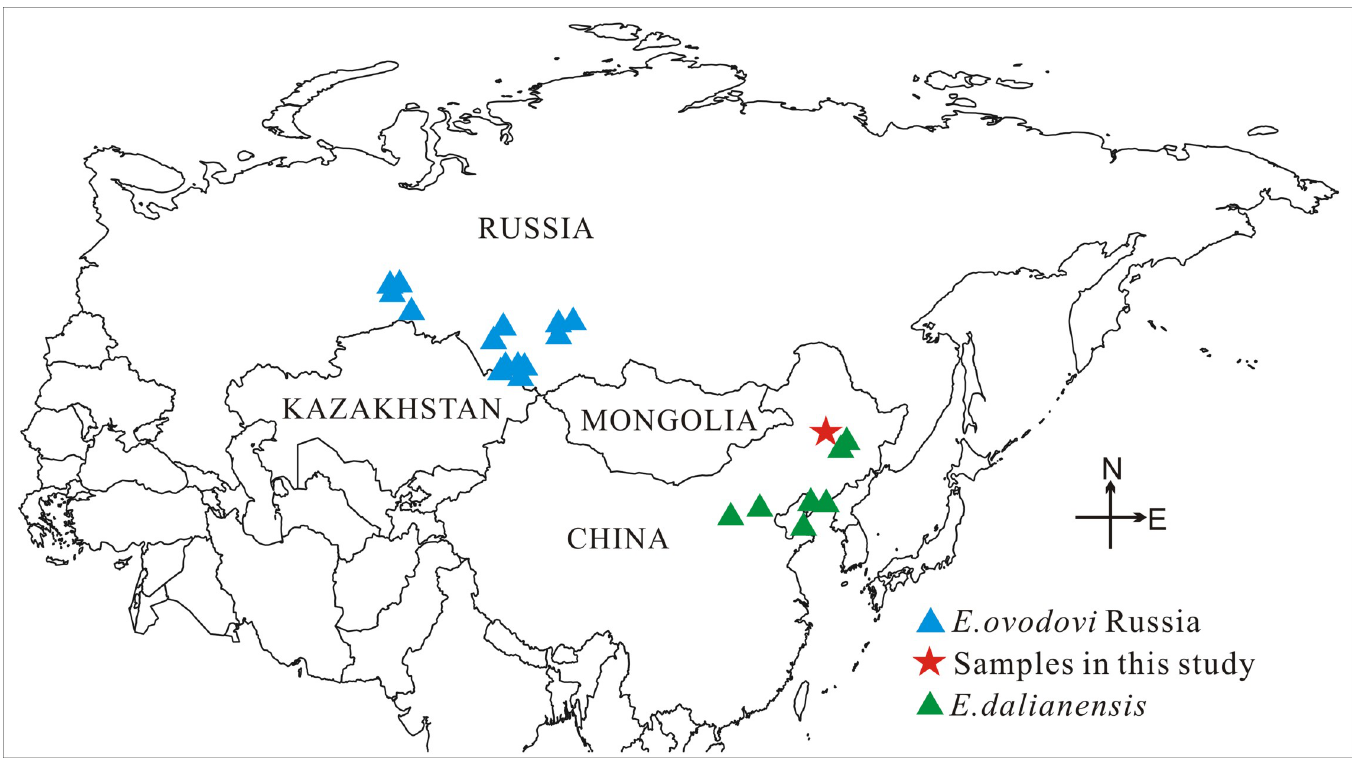
Fig 1. Location of sampling sites in this study and fossil findings of E . ovodovi and E . dalianensis . Sampling site in this study is indicated by a red star; the E . ovodovi specimens in Russia are shown by blue triangles; fossil findings of E . dalianensis according to the literature are shown by green